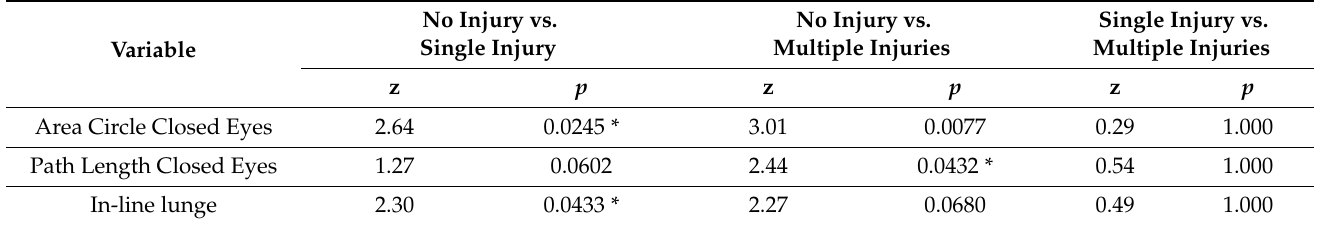
Table 3. Post-hoc (Dunn test)